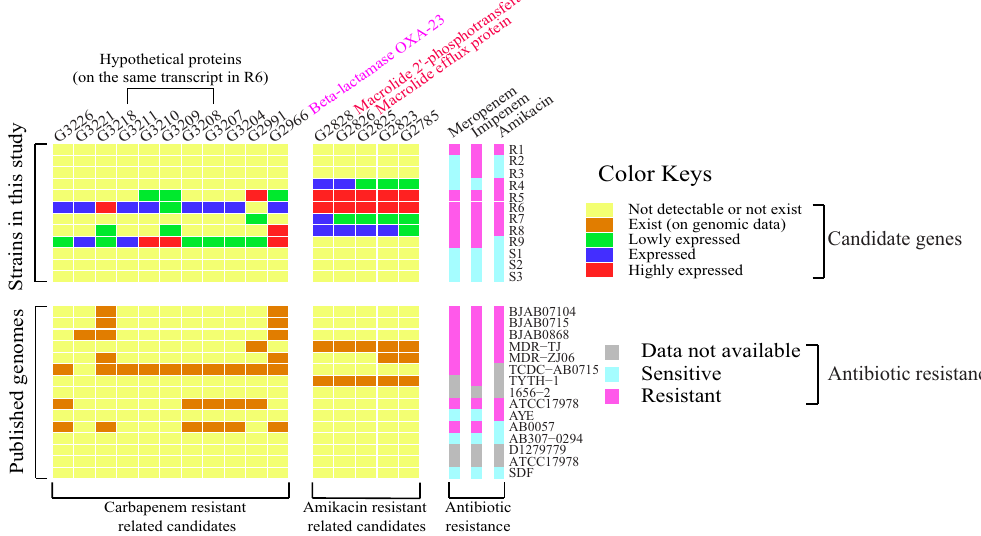
Figure 5. Identification of novel antibiotic-specific resistance genes. Each square represents the expression level or the presence of a gene (down the column) in a given strain (across the row). The resistance of each strain to the three antibiotics is shown on the right